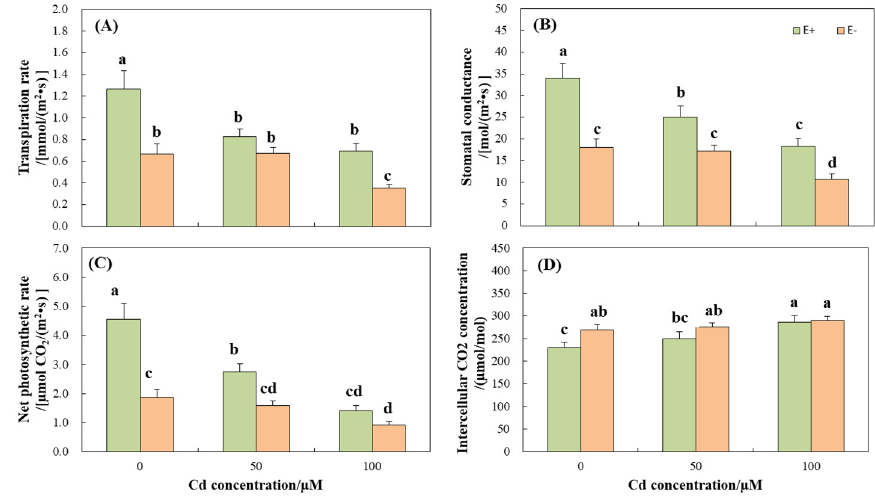
Figure 3. Photosynthetic parameters of Hordeum brevisublatum under different concentrations of CdCl 2 stress. ( A ) Transpiration rate, ( B ) Stomatal conductance, ( C ) Net photosynthetic rate, and ( D ) Concentration of CO 2 intercellular. E+: endophyte ‐ infected and E − : endophyte ‐ free. The values presented are mean ± standard error (SE). Lowercase letters (a–d) on top of the bars indicate significant differences ( p < 0.05) of E+ and E − plants under the different concentrations of CdCl 2 stress.